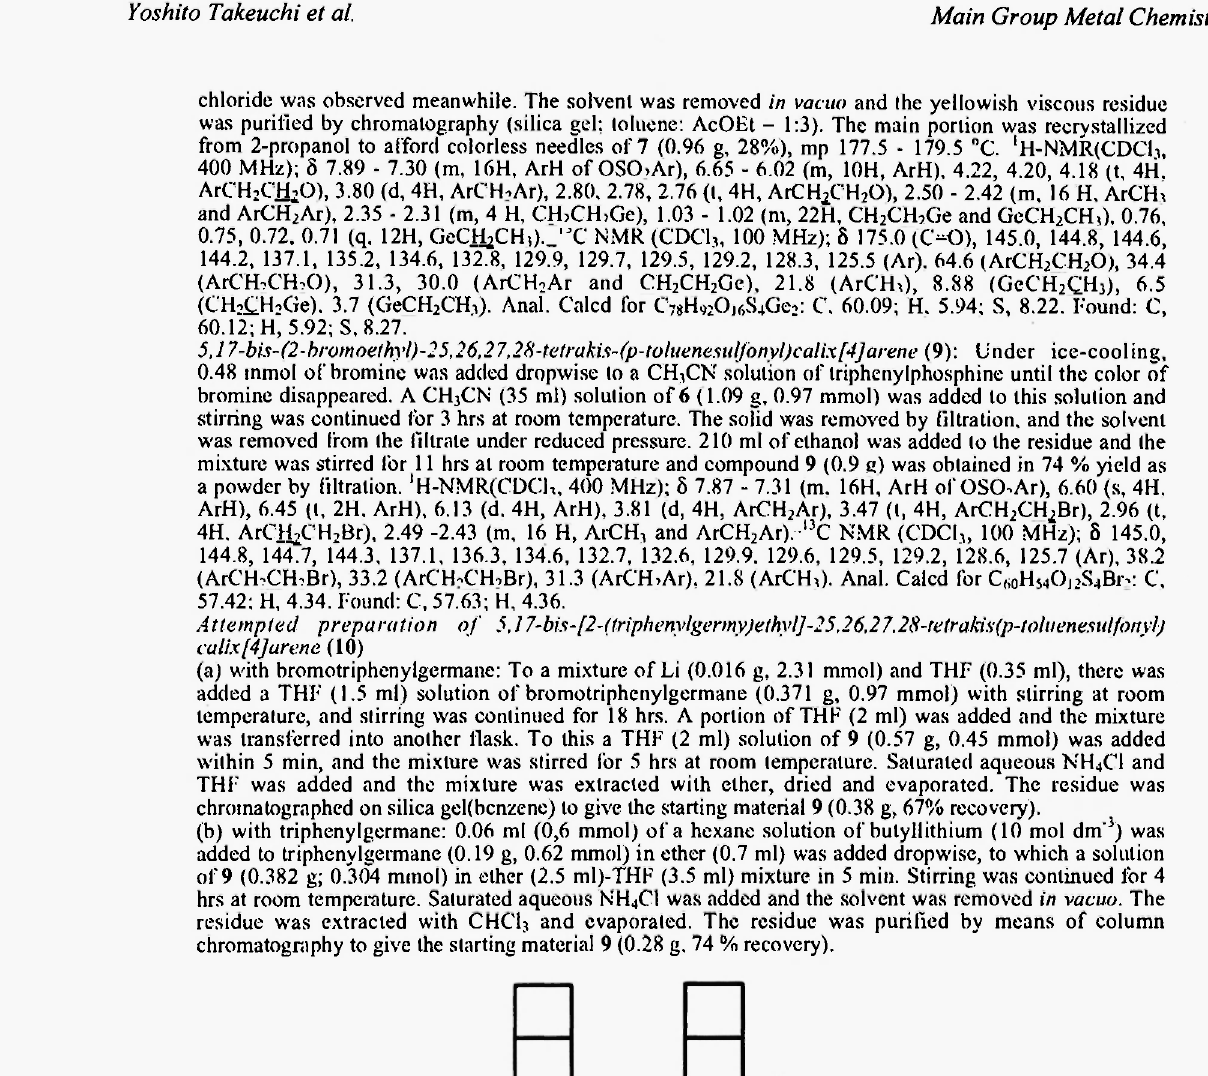
Figure 2. Cation Transport Measurement by Η-tube